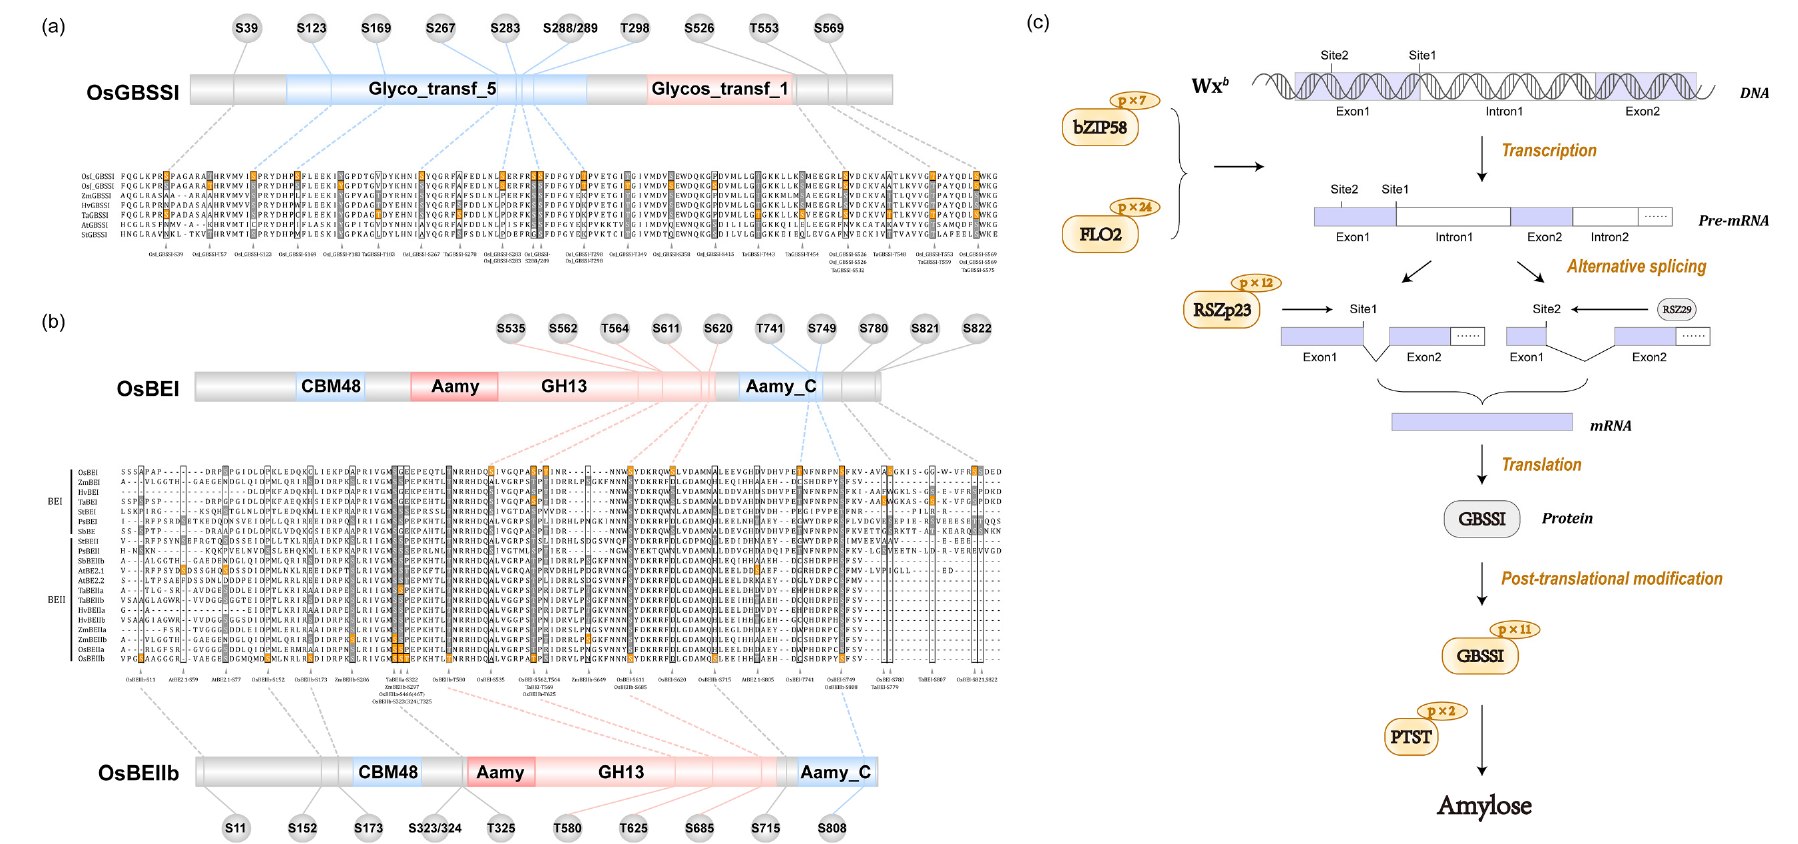
Figure 6. Domain structure and amino acid sequence alignments of GBSSI ( a ) and BEs ( b ). Residues in yellow indicate the phosphorylation site. Non-phosphorylated residues are shown in dark gray. ( c ) Potential effect of phosphorylation regulation on amylose biosynthesis by regulatory factors (OsbZIP58 and FLO2), RSZp23, GBSSI, and